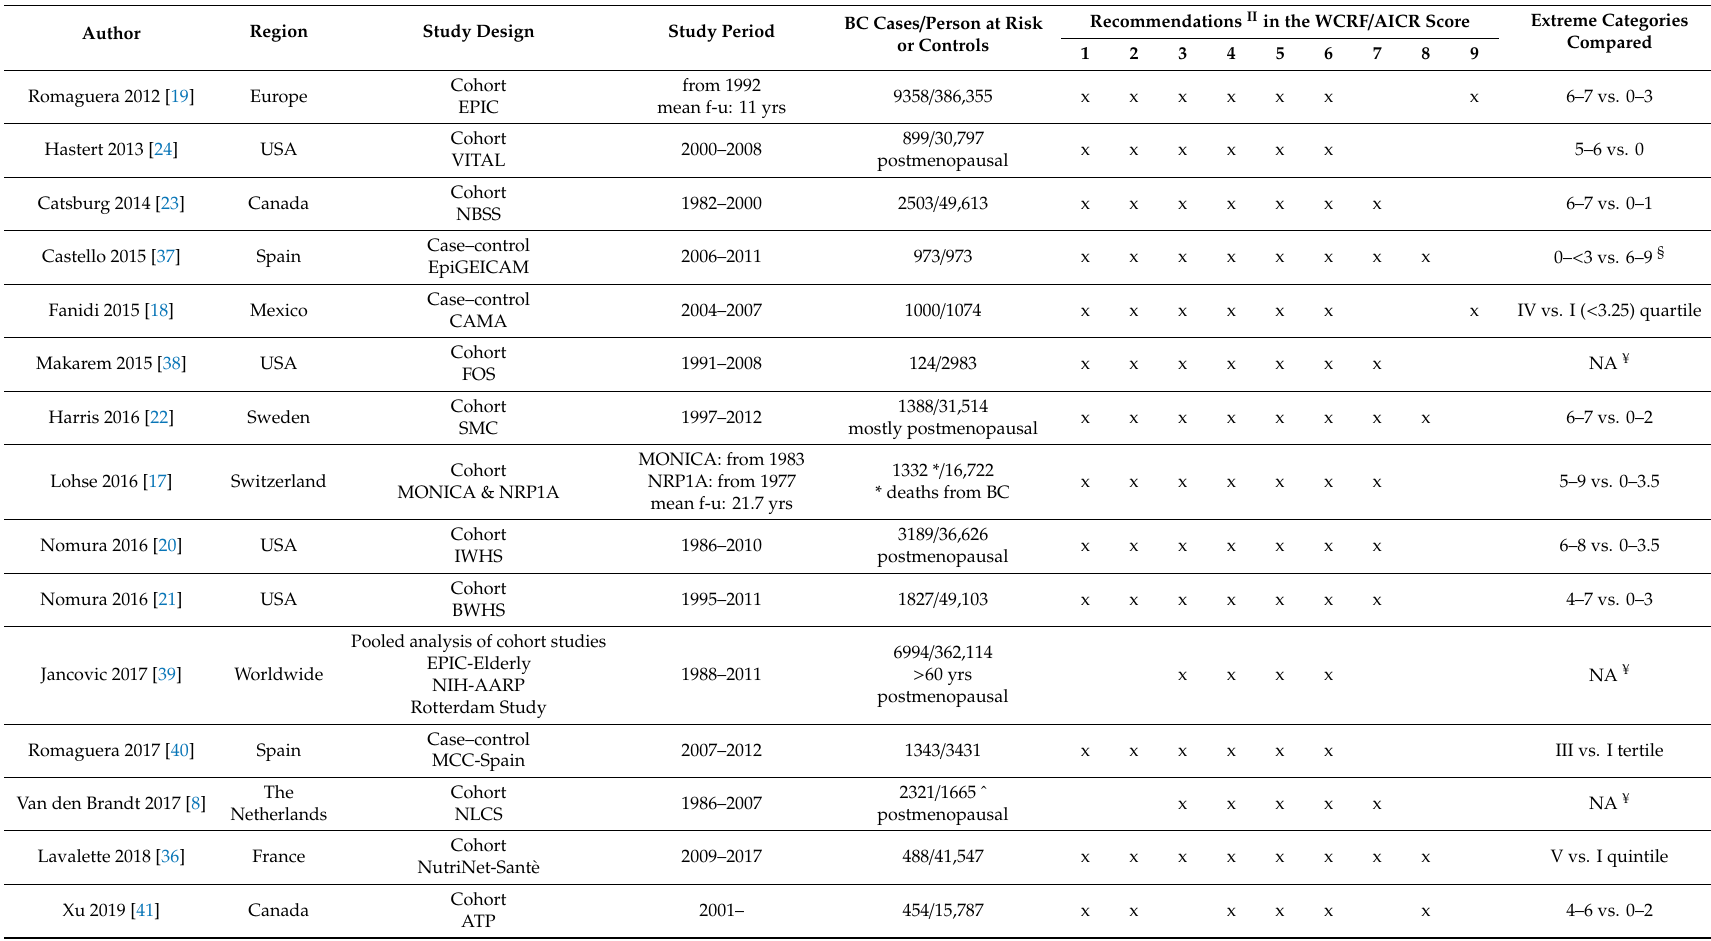
Table 4. Characteristics of the studies included in the